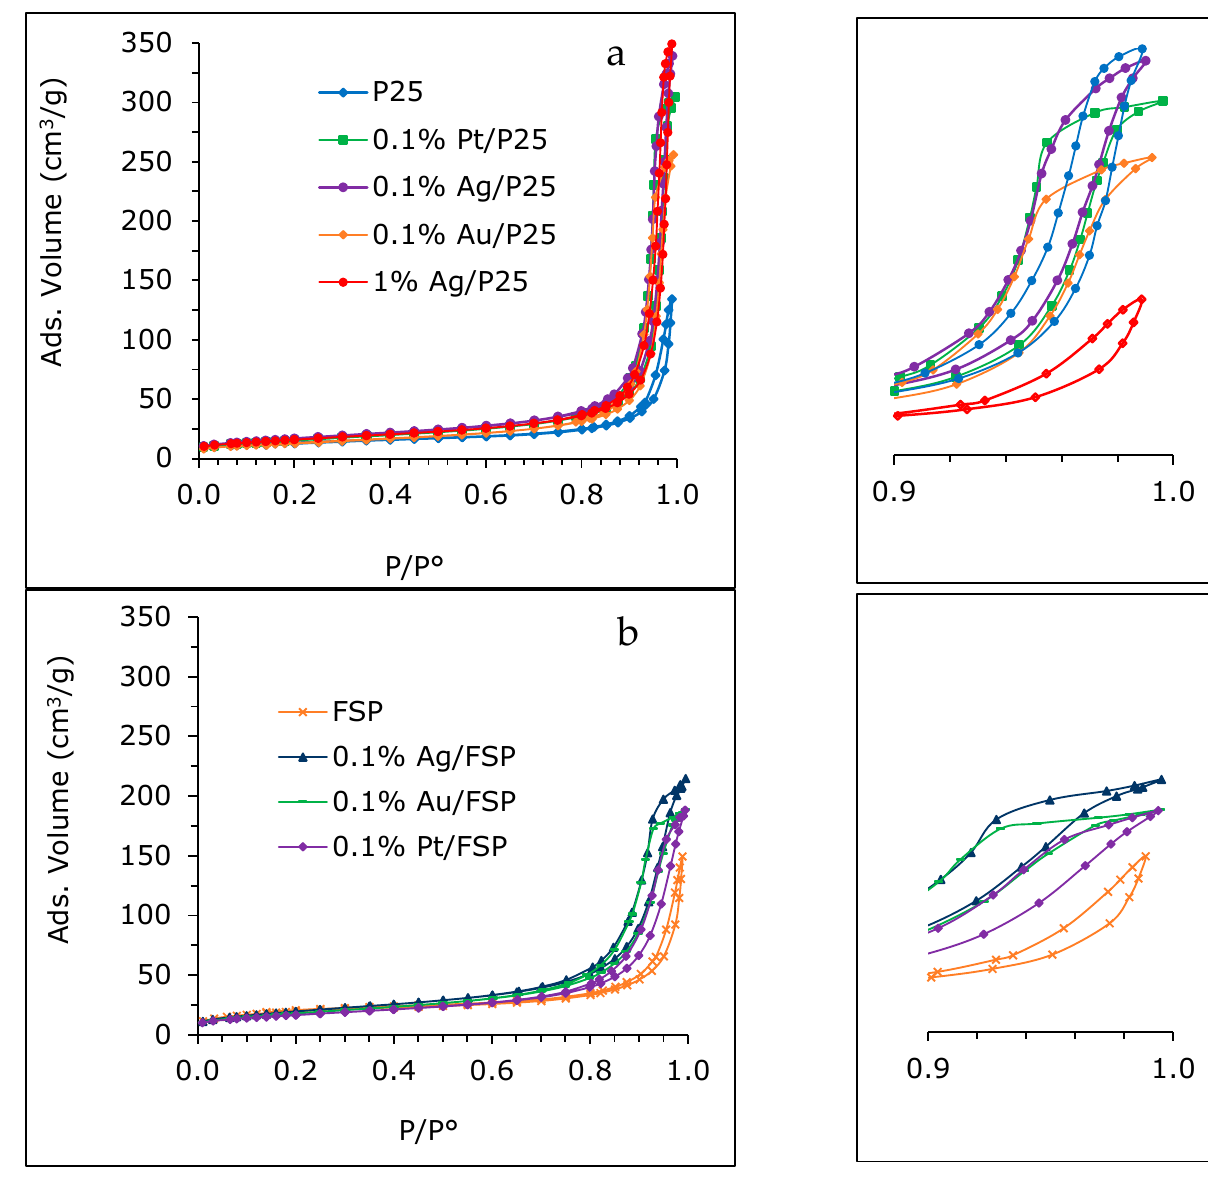
Figure 1. BET adsorption-desorption isotherms of selected catalysts. Adapted from [25]. ( a ) Samples supported on P25 Titania; ( b ) samples supported on FSP Titania.